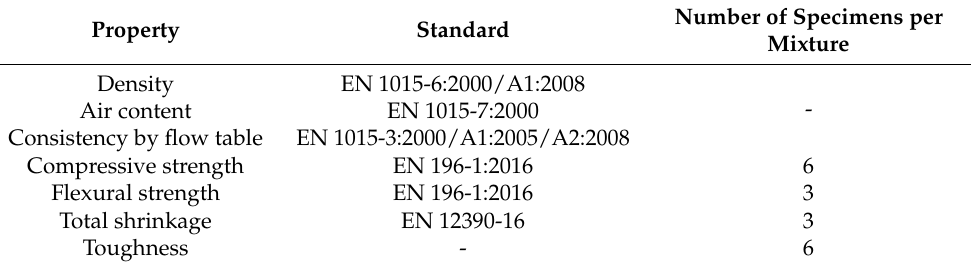
Table 4. Test methods for characterization of mortar properties.